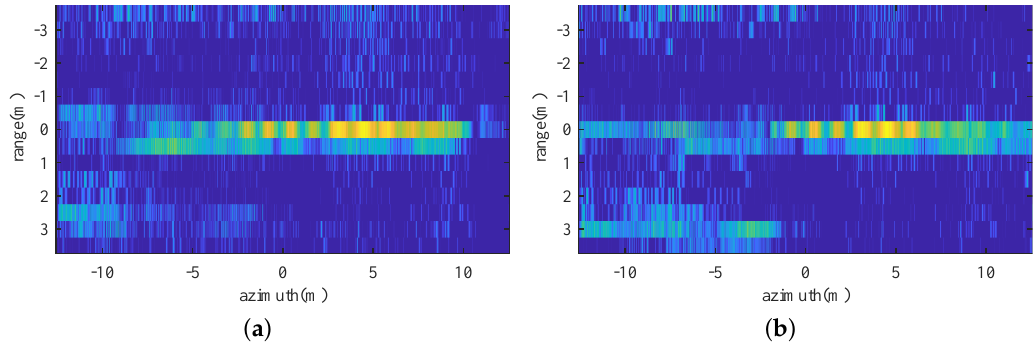
Figure 6. Range profiles: ( a ) before MoCo, ( b ) after